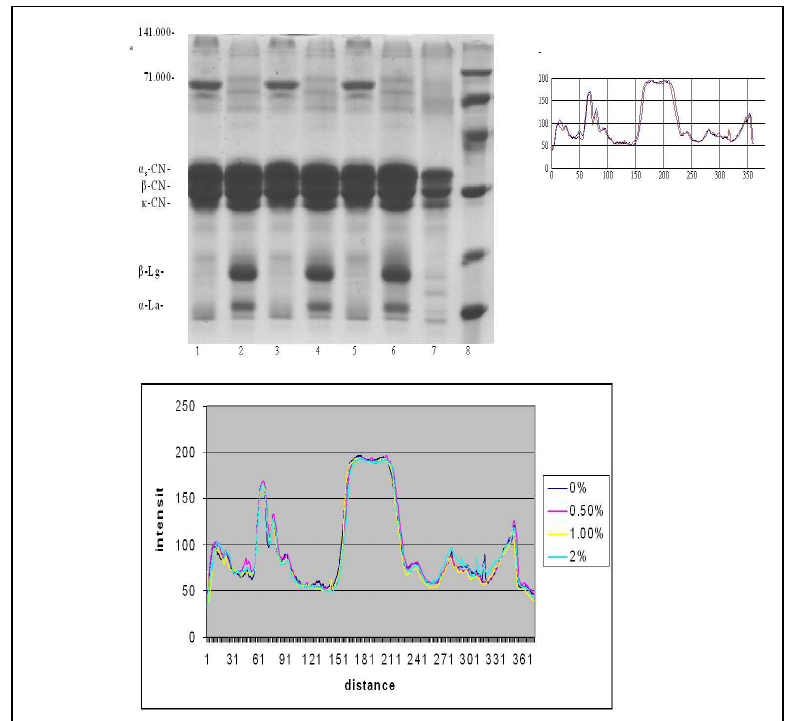
Figure 6. The electrophoretic* and comparative densitometric analysis of the reconstituted skim milk with demineralized whey added, treated at 85 °C for 20 minutes. a. The electrophoretic analysis of the reconstituted milk with 0.5% (1, 2), 1.0% (3, 4), and 2.0% (5, 6) of demineralized whey added; Na- caseinate (7) and molecular weight standards (8). b. The comparative densitometric analysis of the heat treated samples, treated without (-) and with (-) 0.5% of the demineralized whey c. Comparative densitometric analysis of the samples treated with 0%, 0.5%, 1% and 2.0% of the demineralized whey